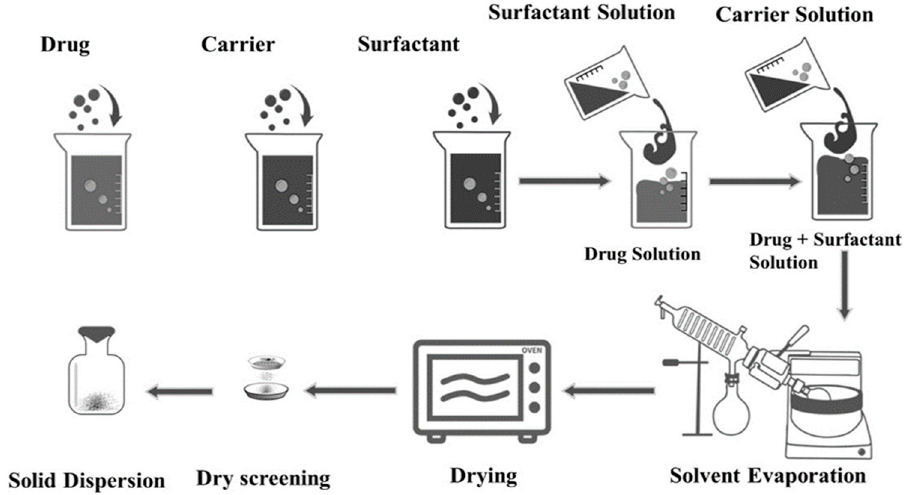
Figure 2. Preparation of ternary solid dispersions.